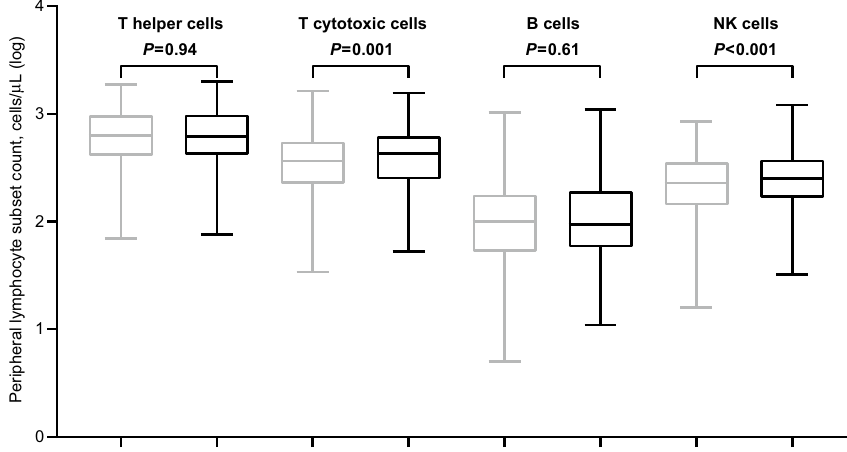
Figure 1. Dynamic changes in peripheral lymphocyte subpopulation counts. Bars represent median values with 95% confidence intervals. Differences between groups were assessed using the Wilcoxon signed-rank test. A two-sided P value of < 0.05 was considered statistically significant. Log, logarithmic; T helper cells, CD3 + CD4 + cells; T cytotoxic cell, CD3 + CD8 + ; B cells, CD19 + ; NK, Natural killer, CD16 + CD56 + . Timepoint-1 denotes assessment before the third dose of tozinameran; Timepoint-2 denotes assessment four weeks after the third dose of tozinameran.